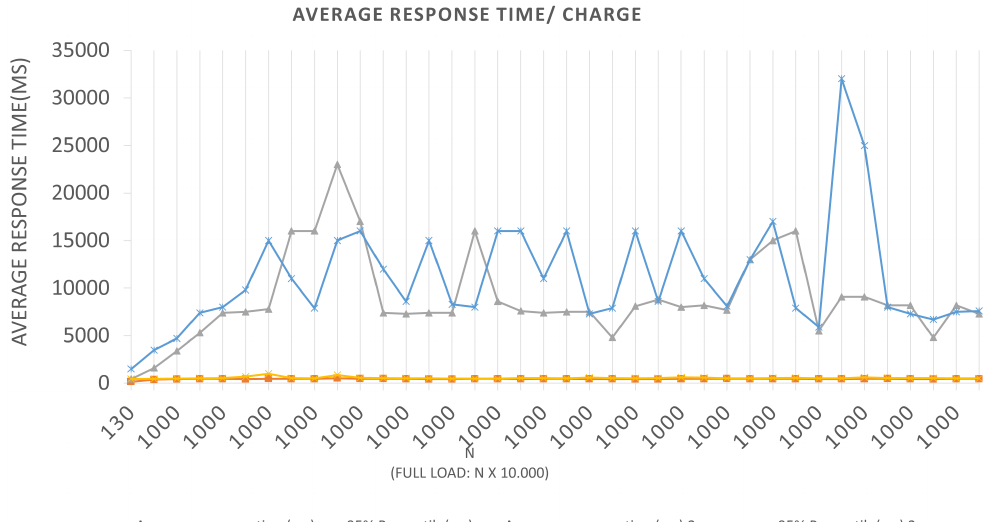
Figure 10. Results of the experiments for query